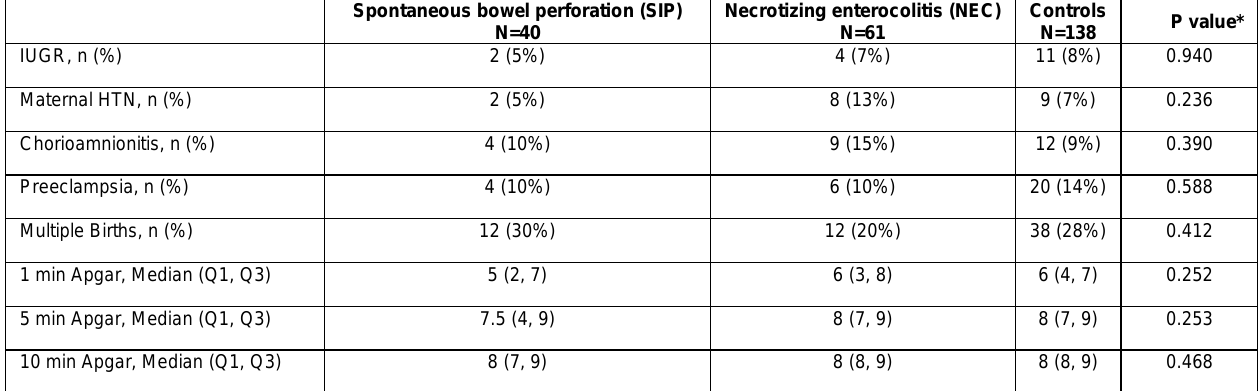
Table 3. Characteristics contributing to perinatal stress Spontaneous bowel perforation (SIP)